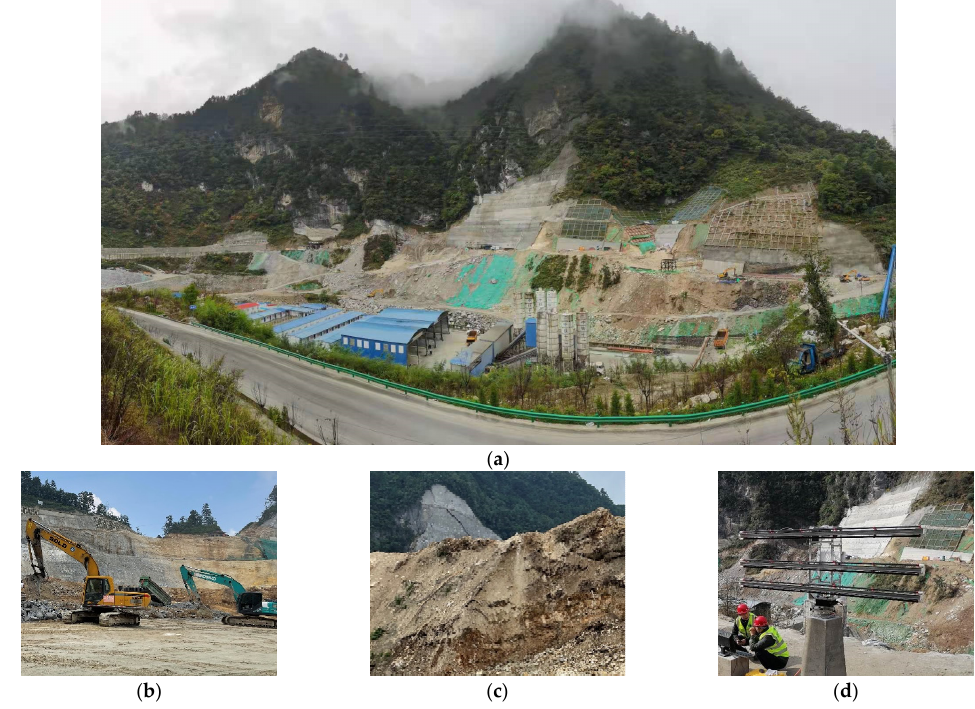
Figure 2. ( a ) Panorama of the downstream Zhen’an pumped-storage power station. ( b ) Excavation construction. ( c ) Exposed slope ( d ) GB-InSAR long-term observation point. Table 1. The main parameters of GPRI-II .